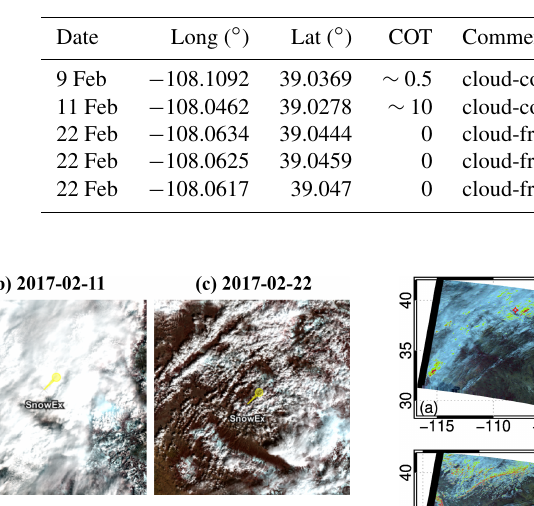
Figure 6. Zoom of the RGB composition figures (created using ESA official SLSTR software SNAP) for the three selected dates presented in Table 3. The yellow point indicates the SnowEx instru- ment position.